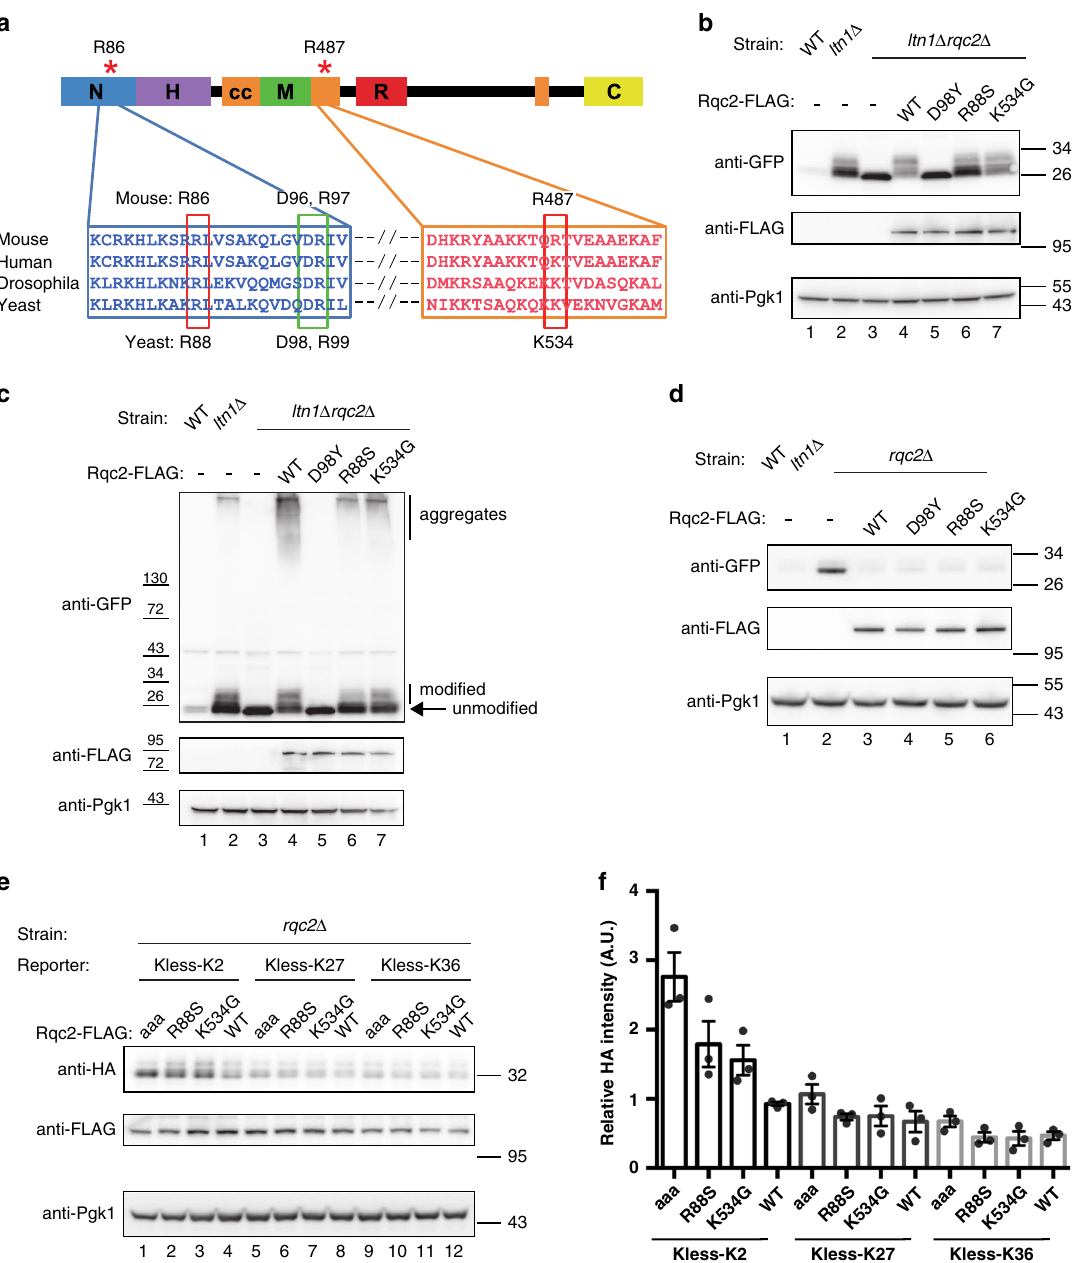
Fig. 4 Nemf ENU mutations selectively affect the CATylation function of Rqc2. a Domain diagram and partial alignment of mouse NEMF and homologs — human NEMF, fl y Caliban, and yeast Rqc2. Sequences fl anking residues affected by the ENU mutations are shown. Domains and motifs depicted: NFACT-N (N), helix – hairpin – helix (H), coiled-coil (cc), middle domain (M), NFACT-R (R), and NFACT-C (C). NEMF Arg86 and Arg487 mutated in Nemf ENU mice (* and red rectangles), and yeast Rqc2 Asp98 and Arg99 residues previously implicated in CAT tail synthesis (green rectangle) are indicated. b WT, ltn1 Δ , or ltn1 Δ rqc2 Δ cells were transformed with the GFP-R12-RFP (GRR) stalling reporter and plasmids encoding Rqc2-FLAG WT, CATylation-de fi cient D98Y mutant, or ENU-equivalent mutants (R88S and K534G). Immunoblots: anti-GFP and anti-FLAG to monitor reporter and Rqc2 levels, respectively, and anti- Pgk1 as loading control. c Strains transformed with Rqc2-FLAG and the GRR stalling reporter, as indicated. Immunoblot anti-GFP monitored reporter modi fi cation and aggregation. d Wild-type (WT) and RQC2 -deleted ( rqc2 Δ ) cells were transformed with the GRR stalling reporter, and indicated Rqc2- FLAG constructs and analyzed as in “ b ” . e Kless-K2, -K27, or -K36 reporters (see Supplementary Fig. 8) expressed in rqc2 Δ cells together with Rqc2-FLAG WT, the CATylation-de fi cient Rqc2 aaa mutant (Asp9, Asp98, and Arg99 mutated to Ala), or Rqc2-equivalent ENU mutants as indicated. Anti-HA and anti-FLAG blots monitored reporter and Rqc2 expression, respectively. f As in panel “ f ” . Quanti fi cation of reporter levels relative to the Pgk1 internal control from three biological replicates, individual values with means ± SEM. For each blot b – e MW markers in kDa are wild-type Rqc2 (lane 3), or the “ ENU mutant ” Rqc2 proteins (lanes 5 and 6) rescued this rqc2 Δ phenotype in an otherwise wild-type background, indicating that the mutant proteins are competent to bind to ribosomes and stabilize Ltn1 binding.